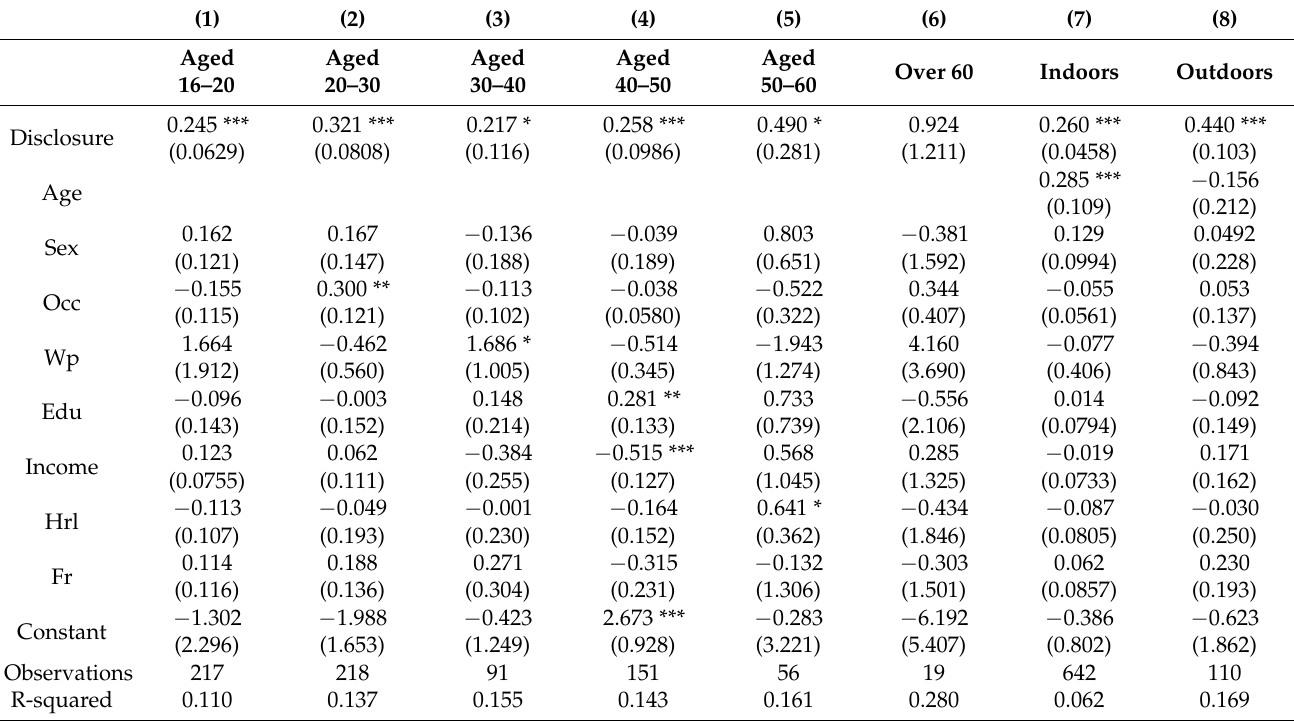
Table 6. Heterogeneity test